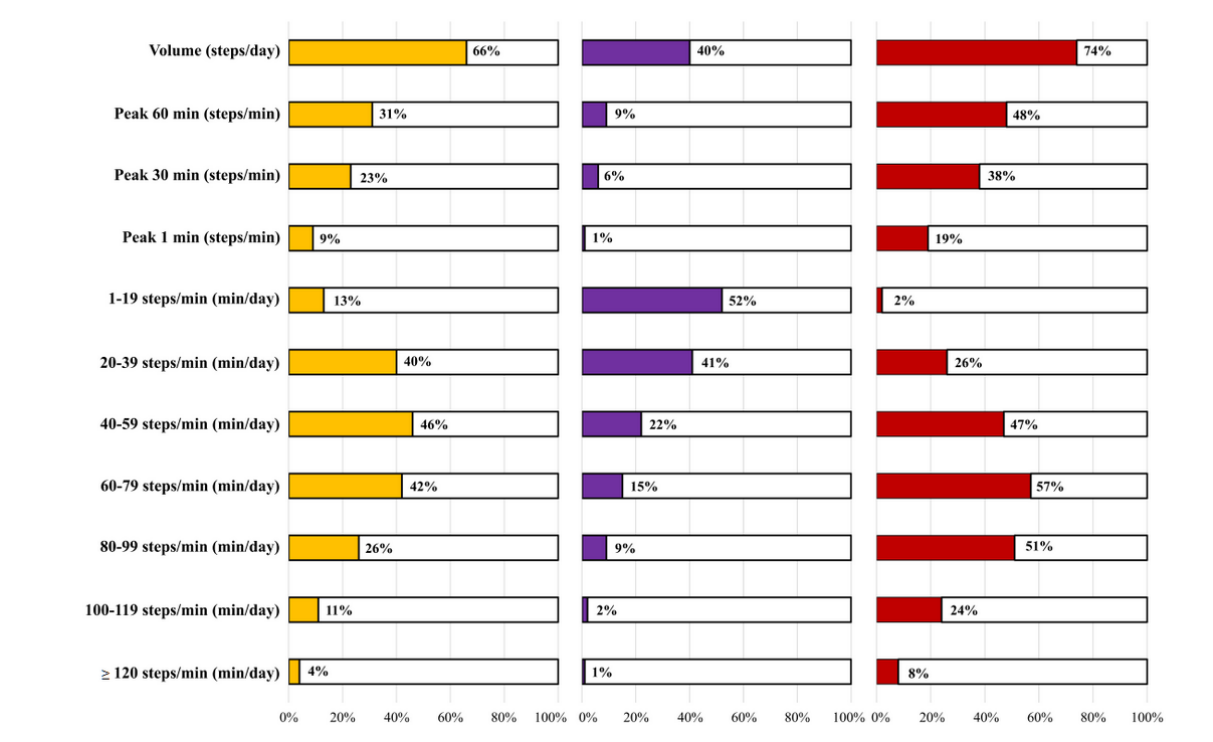
Figure 1. Proportion of variance ( r 2 ) in overall physical activity indicators, which is explained independently by each step-based metric. LMVPA: light-moderate-vigorous physical activity; MVPA: moderate-to-vigorous physical activity.